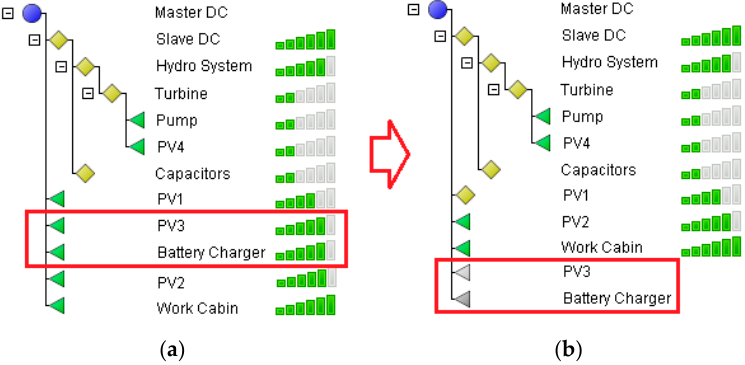
Figure 18. Evolution of PRIME subnetwork during ( a ) stand-by operation and ( b ) on operation of the battery charger. The states of PV3 and Charger SNs change to disconnected when the charger switches on.